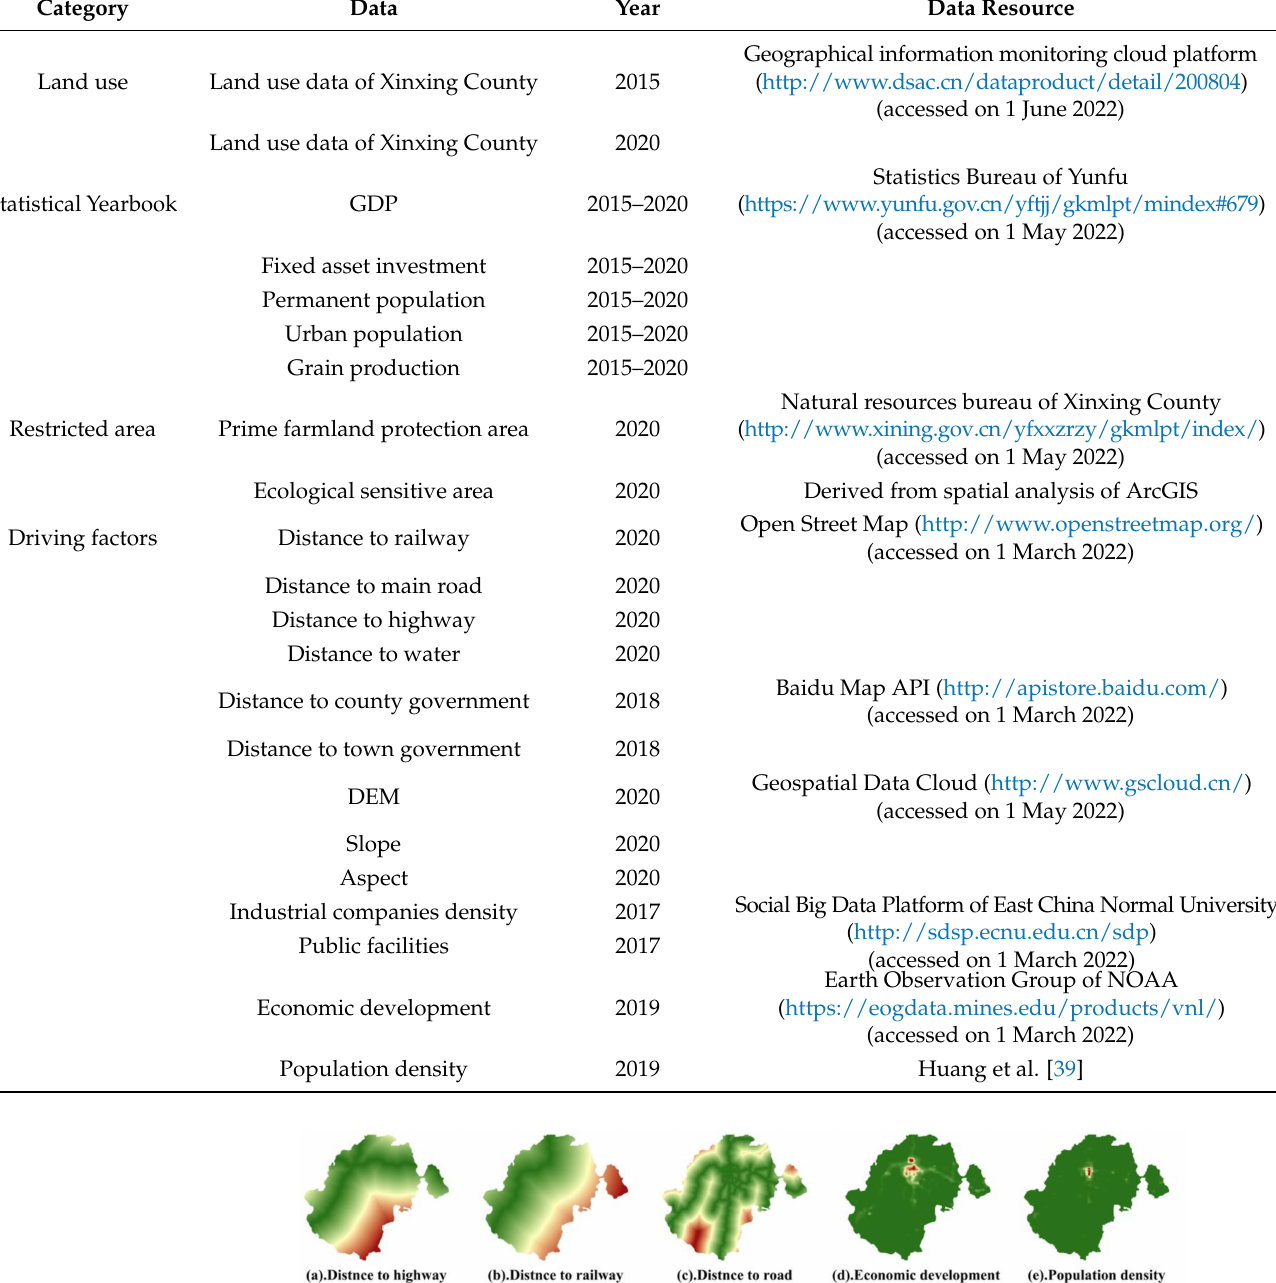
Table 1. List of the data used in this study.